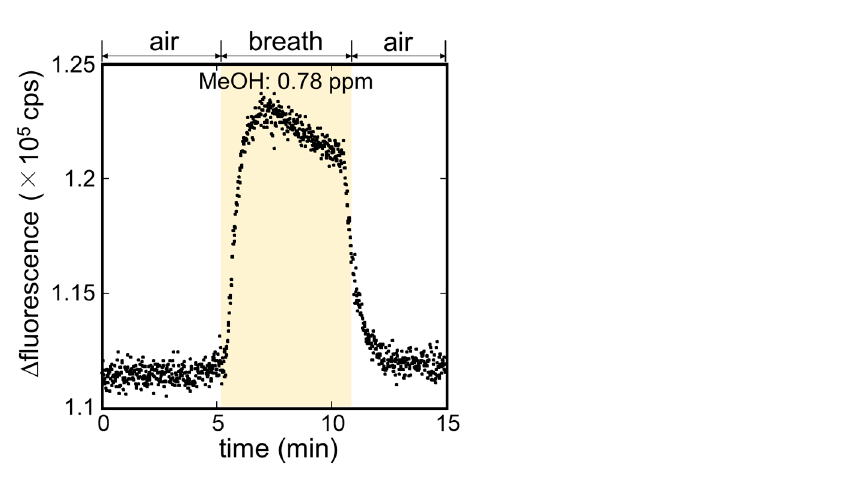
Figure 6. Sensor response to exhaled breath from a healthy subject.